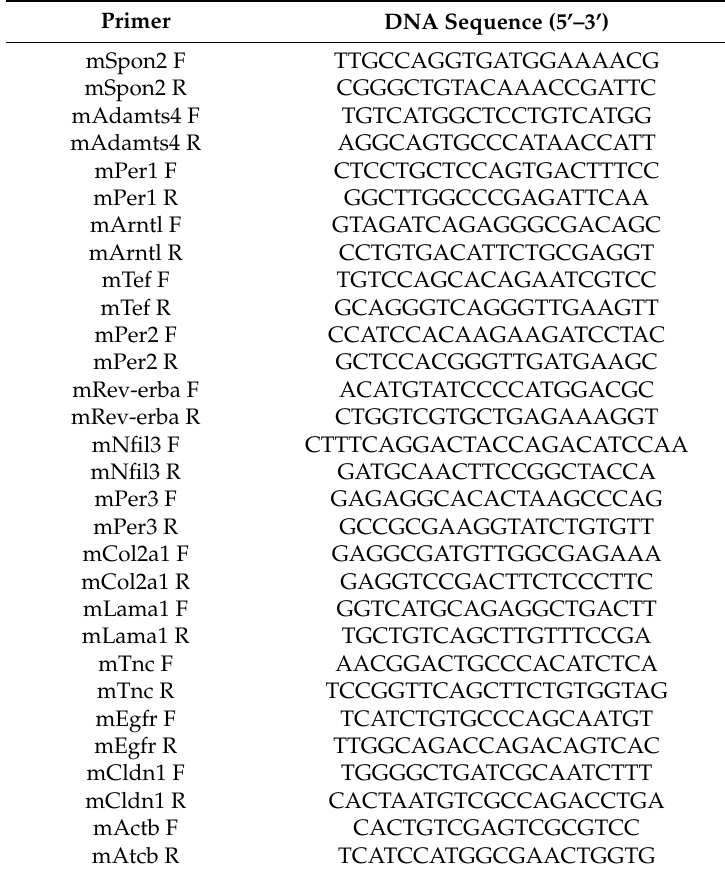
Table 1. List of all primer sequences used for qPCR analysis. Primer DNA Sequence